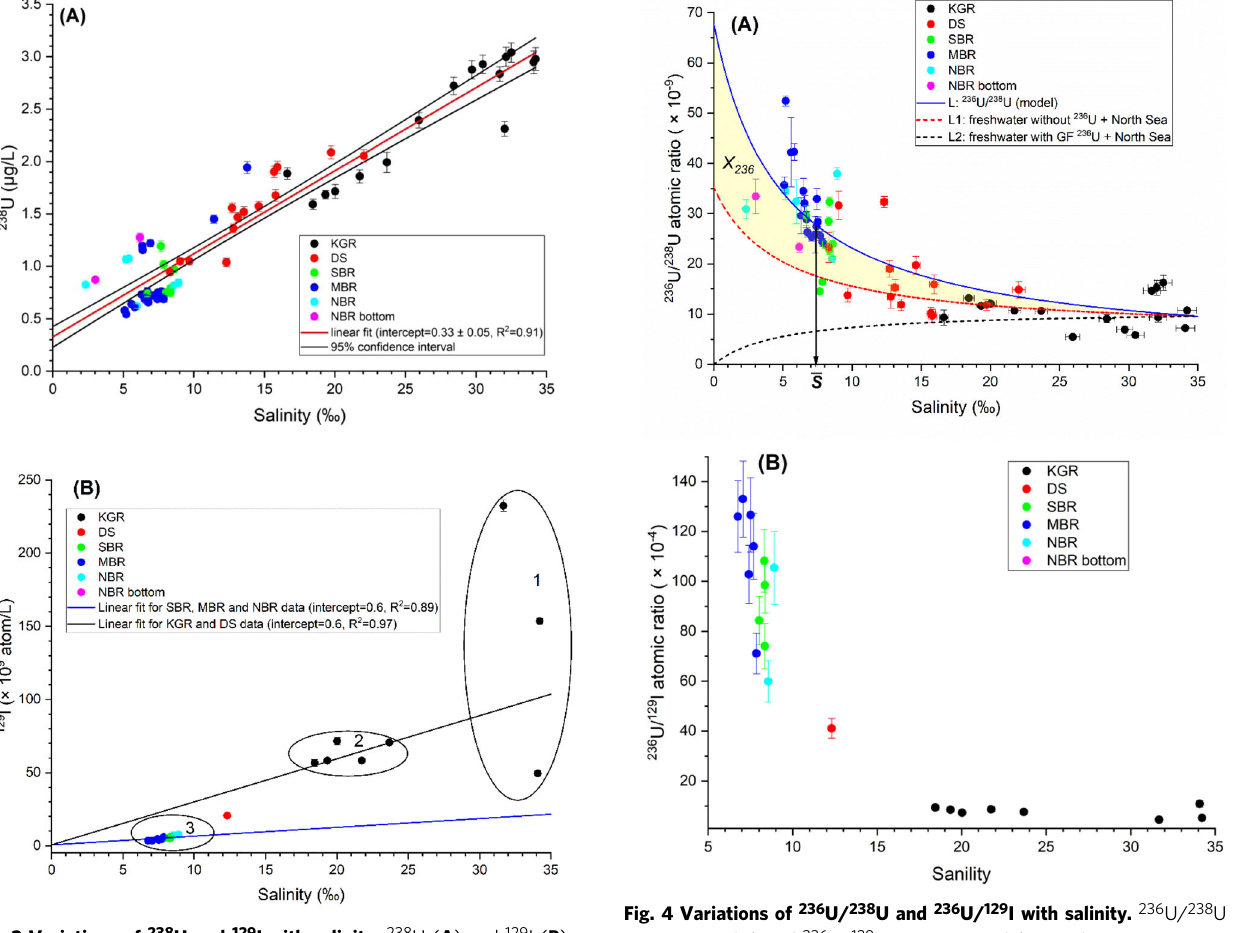
Fig. 3 Variations of 238 U and 129 I with salinity. 238 U ( A ) and 129 I ( B ) concentrations vs. salinity in the Baltic Sea. KGR Kattegat – Skagerrak region including the Kattegat, Skagerrak and Danish west coast nearby the North Sea, DS Danish Straits including the Belt Seas and the Sound, SBR South Baltic Sea region including Arkona Basin, Borholm Basin, and South Baltic Proper, MBR Middle Baltic Sea region including Northern Baltic Proper, Western Gotland Basin, Eastern Gotland Basin and Gulf of Riga, NBR North Baltic Sea region including Archipelago and Åland Sea, Bothnian Sea and Bothnian Bay. The zones (1 – 3) in B refer to dominant water mass: 1 — North Sea-North Atlantic water, 2 — Kattegat – Skagerrak water, and 3 — Baltic Sea water. The intercept for linear regression line of 129 I concentration vs. salinity was constrained to 0.6 × 10 9 atom/l according to the reported minimum 129 I concentration in the Baltic river water 22 . Uncertainties are expanded uncertainties using a coverage factor of k = 1. tenfold increase in 236 U/ 129 I suggests that ca. 90% of 236 U in the central Baltic Sea is from local sources. If the source does contain 129 I, the portion of 236 U derived locally must be still larger. To understand the source terms of 236 U in the Baltic Sea, a binary mixing model is applied with two respective end members representing 236 U input from the North Sea and freshwater input via river runoff. Parameters for the fi rst end member representing the North Sea water entering from the west Baltic Sea are well de fi ned by previous studies (Supplementary Table 3) 20,29 . The deviation of the observed 236 U/ 238 U atomic ratio in the binary mixing (line L1, Fig. 4A) of the North Sea water and an assumed freshwater end member containing no 236 U (neither 233 U) from the best- fi t model L re fl ects additional 236 U sources besides North Sea water. The spatial distribution of deviations in the 236 U/ 238 U atomic ratio enable determination of the location of the additional